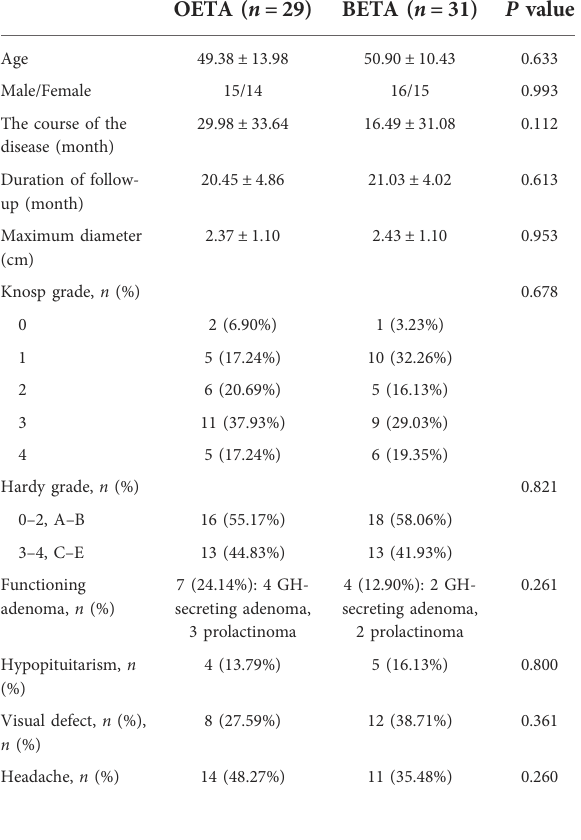
TABLE 1 Patient basic characteristics and pre-op